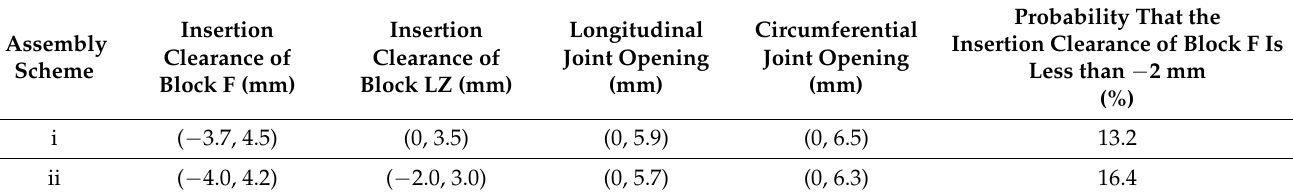
Table 5. Comparison of the key parameters of two assembly